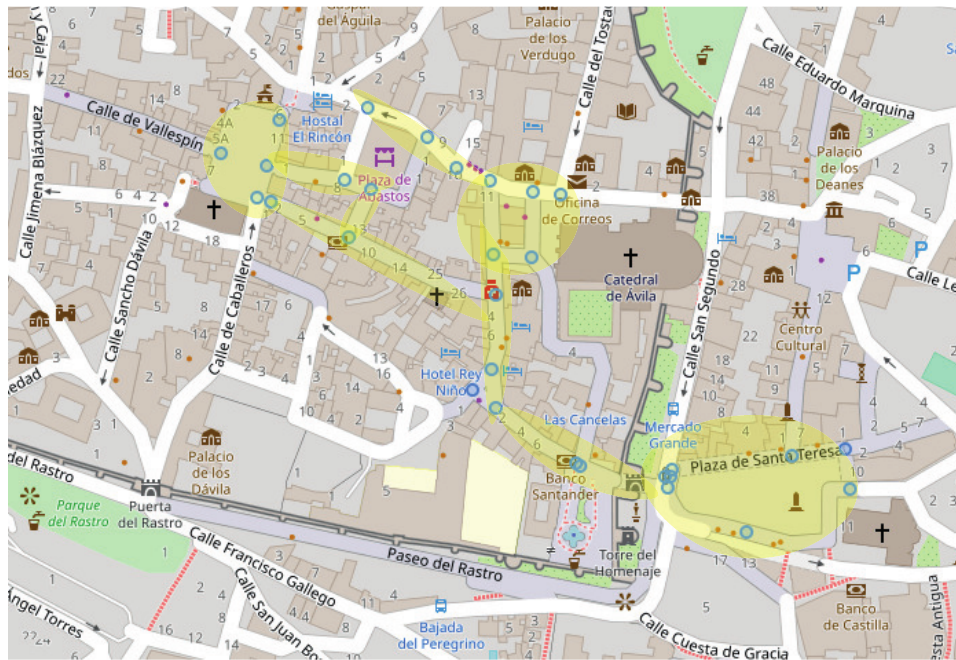
Figure 6. Map of most important areas according to the APA centrality measure.